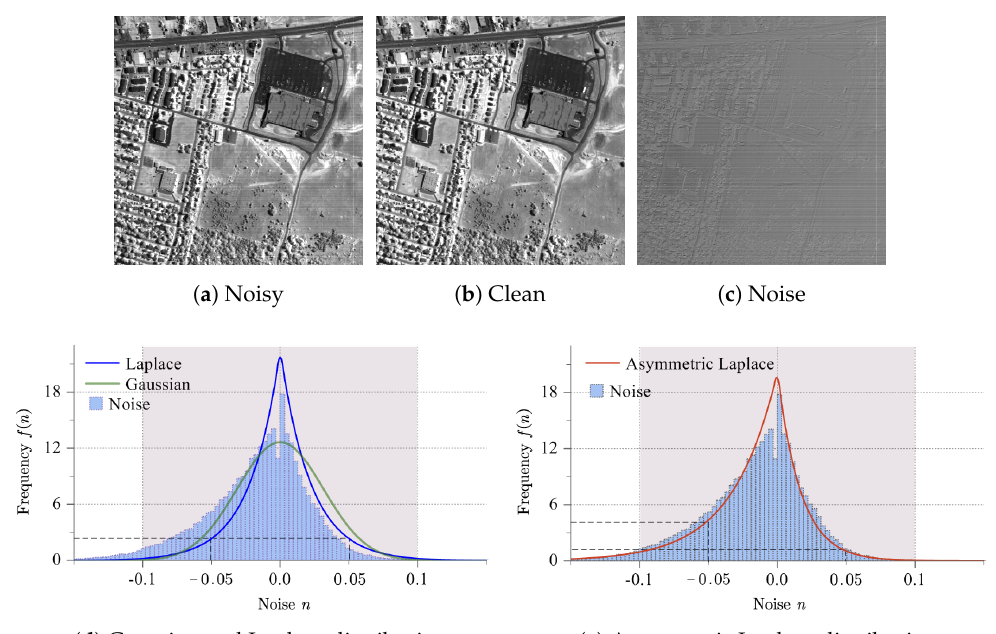
Figure 1. Real − world HSI noise analysis. ( a ) Band 87 of Urban dataset. ( b ) Generated clean band. ( c ) Approximate noise of band. ( d ) Histogram of approximate noise probability density function curves fitted by Laplace distribution and Gaussian distribution, respectively. ( e ) Histogram of approximate noise and probability density function curve fitted by asymmetric Laplace